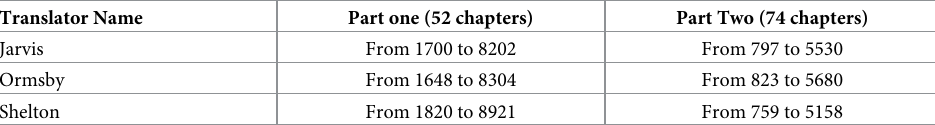
Table 2. Number of words per chapter in the dataset for each translator of Don